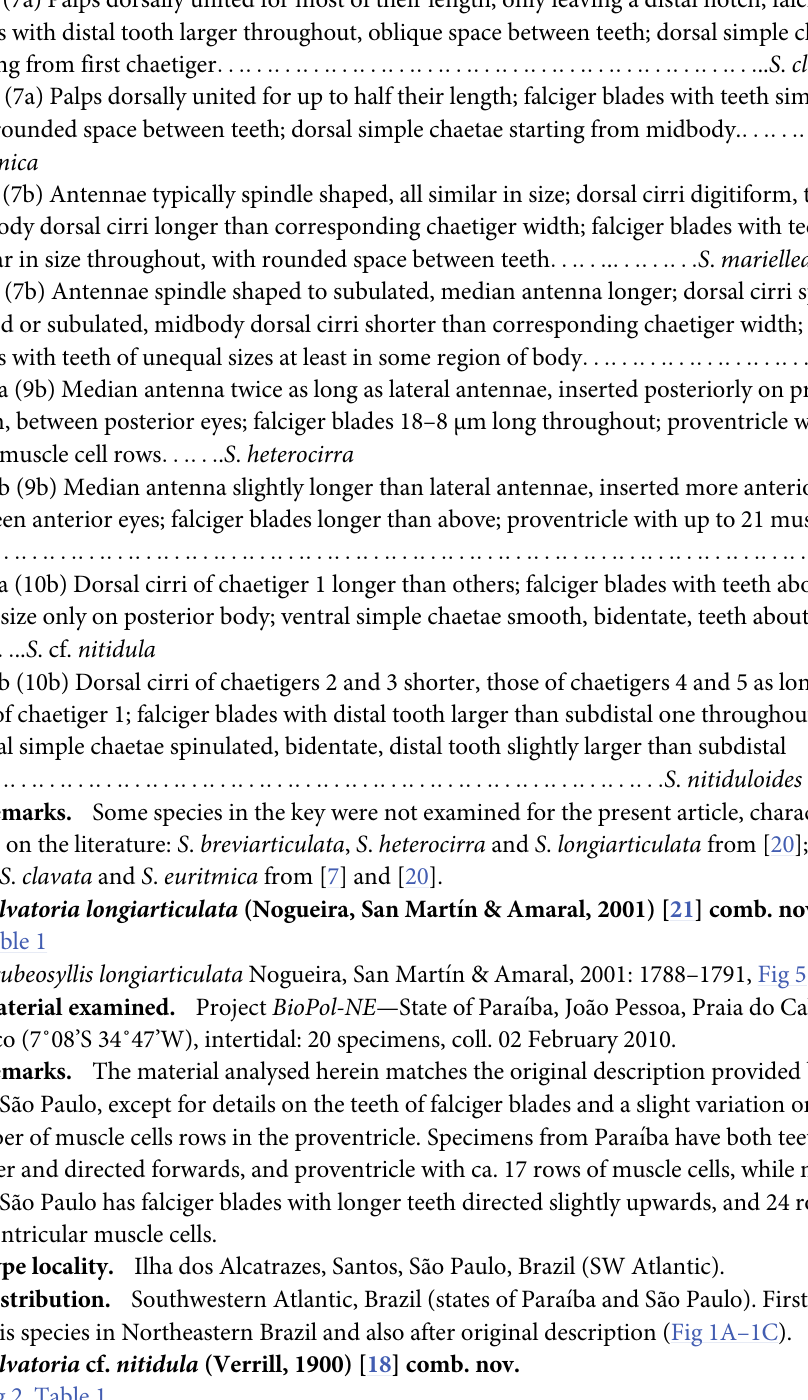
Material examined. Project BioPol-NE —State of Paraı´ba, Jo ã o Pessoa, Praia do Cabo Branco (7˚08’S 34˚47’W), intertidal: 20 specimens, coll. 02 February 2010. Remarks. The material analysed herein matches the original description provided by [21] from S ã o Paulo, except for details on the teeth of falciger blades and a slight variation on the number of muscle cells rows in the proventricle. Specimens from Paraı´ba have both teeth shorter and directed forwards, and proventricle with ca. 17 rows of muscle cells, while material from S ã o Paulo has falciger blades with longer teeth directed slightly upwards, and 24 rows of proventricular muscle